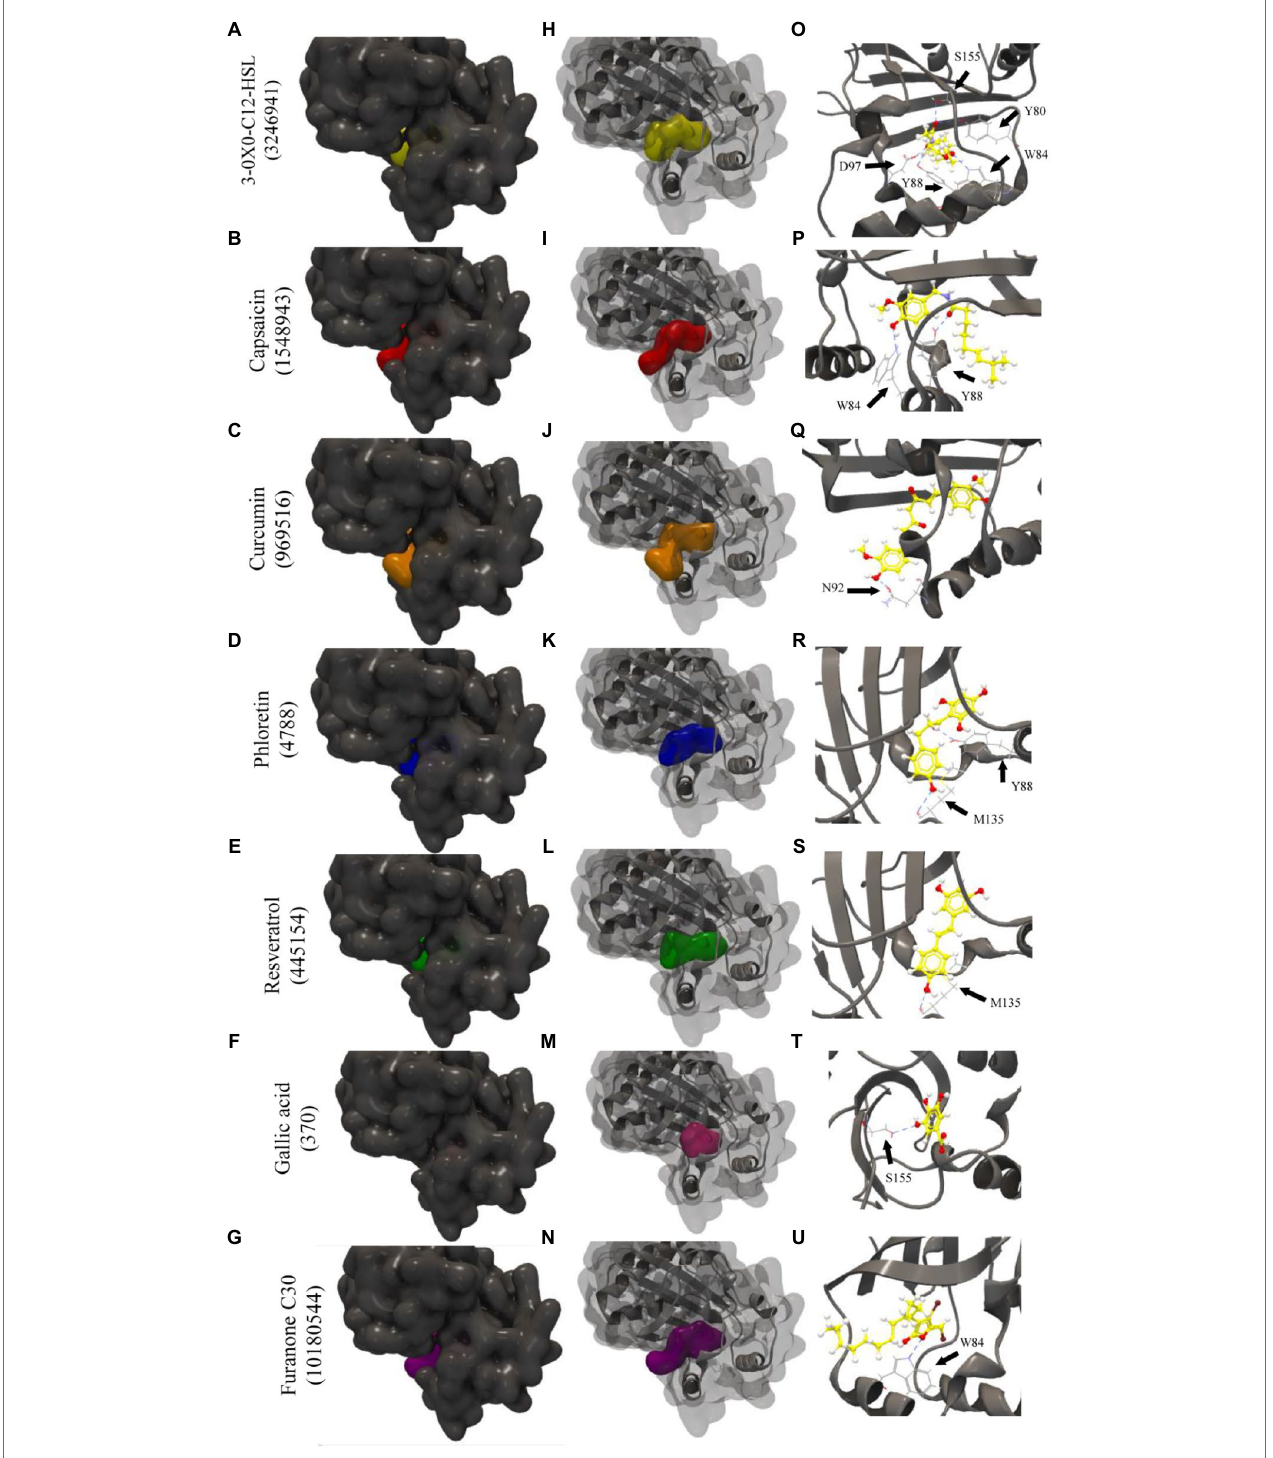
FIGURE 1 | Molecular docking of the 3QP1 protein of CviR QS regulator of Chromobacterium violaceum with 3-oxo-C12-HSL, capsaicin, curcumin, phloretin, resveratrol, gallic acid, and Furanone C30. Surface representation (A–G) ; surface and backbone representations (H–N) ; and backbone representations with hydrogen bonding between amino acid residues and phenolic compounds (O–U) . Gray surface representation: CviR protein; yellow surface representation: 3-oxo- C12-HSL; red surface representation: capsaicin; orange surface representation: curcumin; blue surface representation: phloretin; green surface representation: resveratrol; pink surface representation: gallic acid; and purple surface representation: Furanone C30. Black arrow indicates the binding site by hydrogen